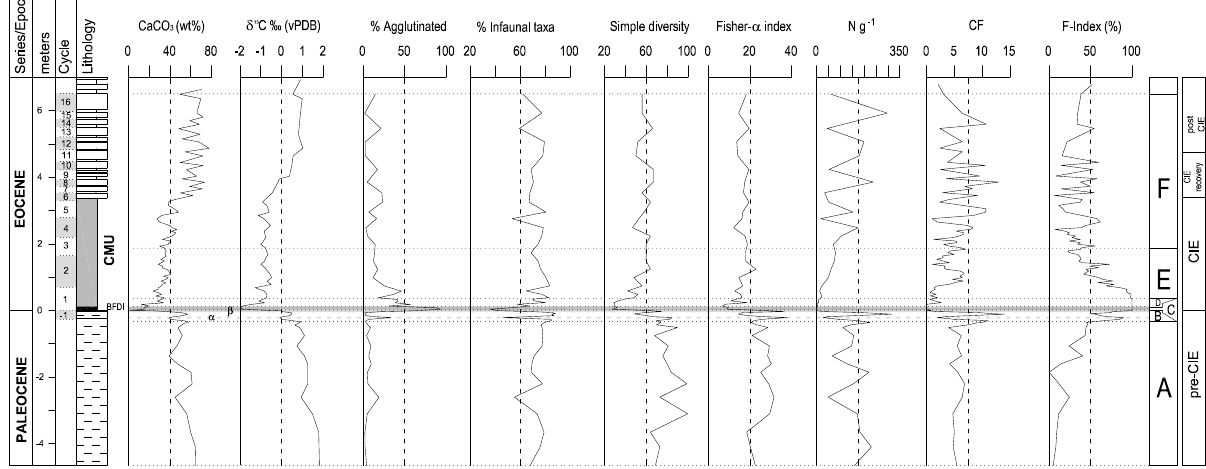
Figure 2. Faunal and geochemical variations across the PETM at the Forada section plotted against chronostratigraphy, precessional cycles, lithology, recognized benthic foraminiferal assemblages (A to F) and isotopic intervals. % agglutinated: agglutinated to agglutinated and cal- careous hyaline ratio; % infaunal taxa: infaunal to infaunal and epifaunal ratio; simple diversity and Fisher- α diversity index; Ng − 1 = number of benthic foraminifera per gram (faunal density) in the >63mm size fraction; coarse fraction (CF) calculated according to Hancock and Dickens (2005) as the weight percent of the >63µm size fraction relative to the weight of the bulk sample; fragmentation index ( F index) is from Luciani et al. (2007). The gray bands indicate intervals of carbonate dissolution. α : pre-CIE dissolution, β : burndown layer; BFDI: benthic foraminiferal dissolution interval.